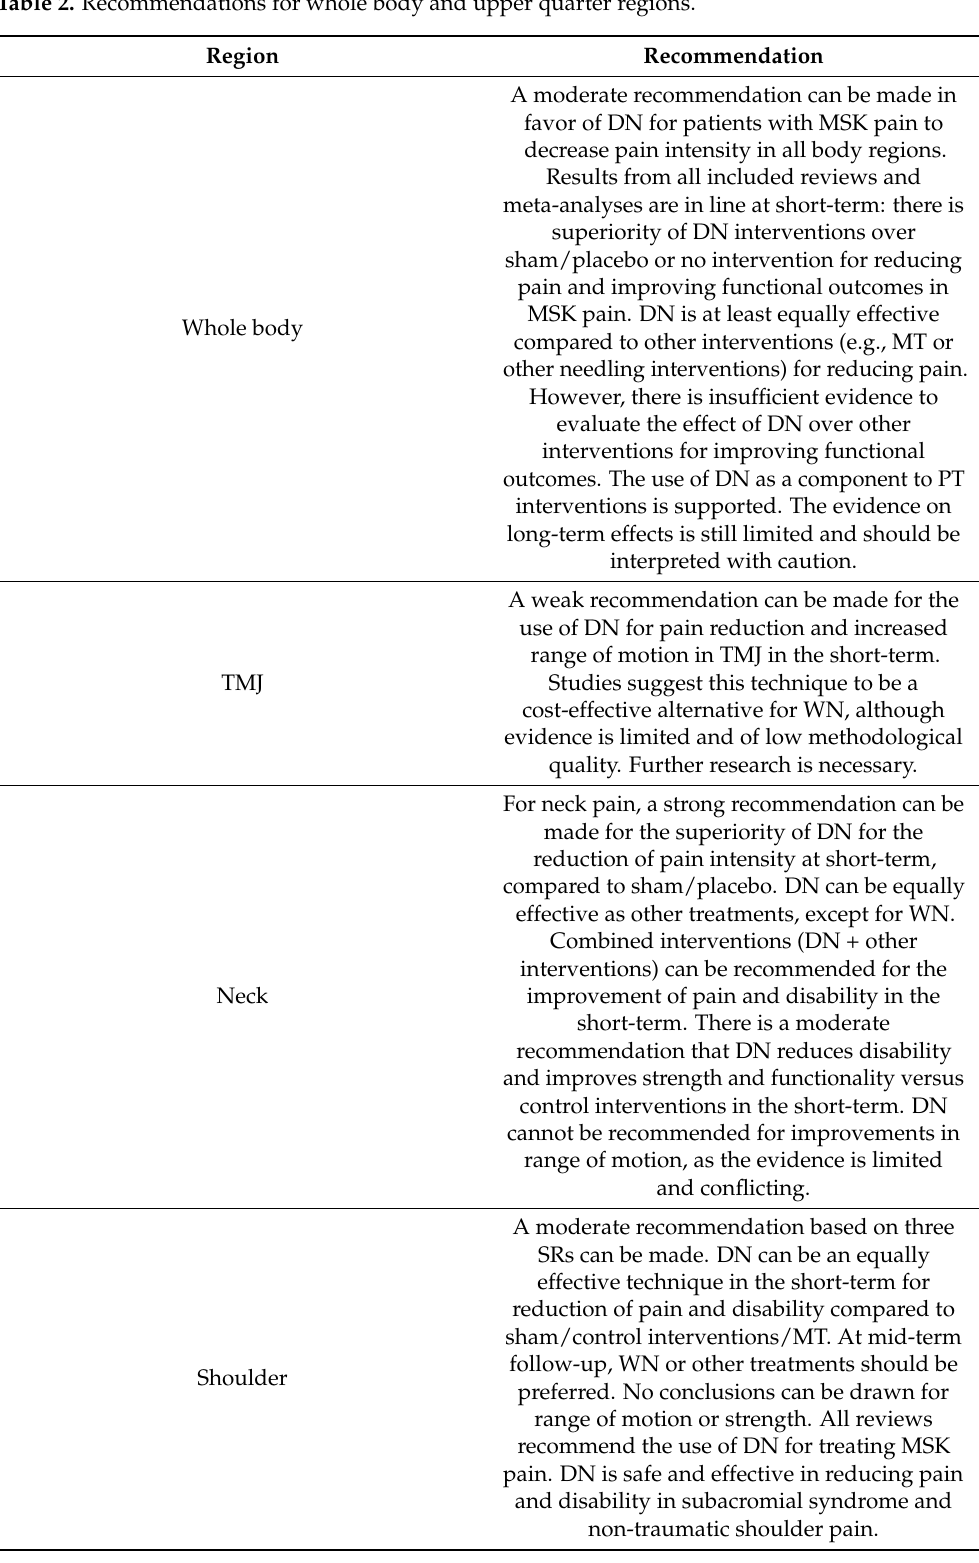
Table 2. Recommendations for whole body and upper quarter